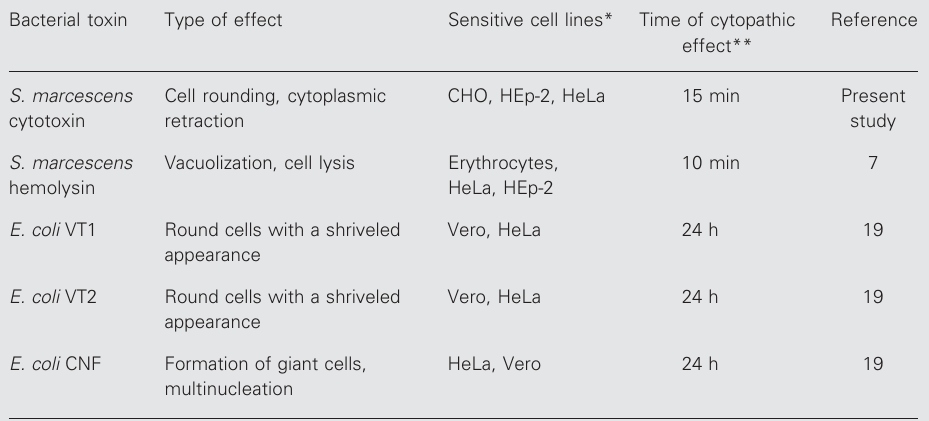
Table 1. Characteristics of toxins that were compared with Serratia marcescens cytotoxin in this